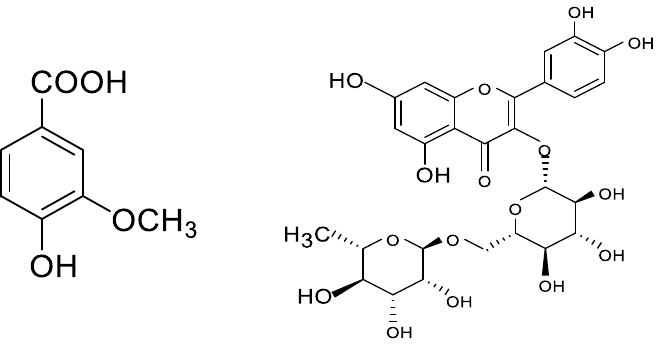
Figure 1. The chemical structures of sinapic acid, syringic acid, and rutin, accordingly.